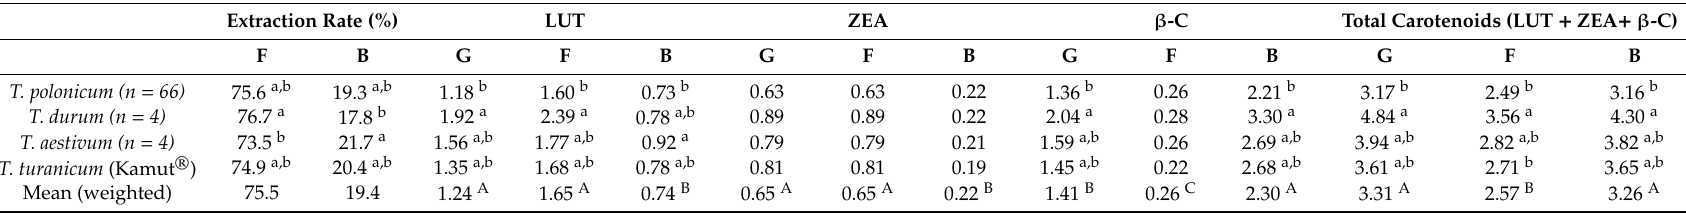
Table 2. Flour extraction rates, bran yield, and carotenoid concentrations (mg kg − 1 ) in the grain and both milling fractions of the analyzed Triticum species. Extraction Rate (%) LUT ZEA β -C Total Carotenoids (LUT + ZEA + β -C) F B G F B G F B G F B G F